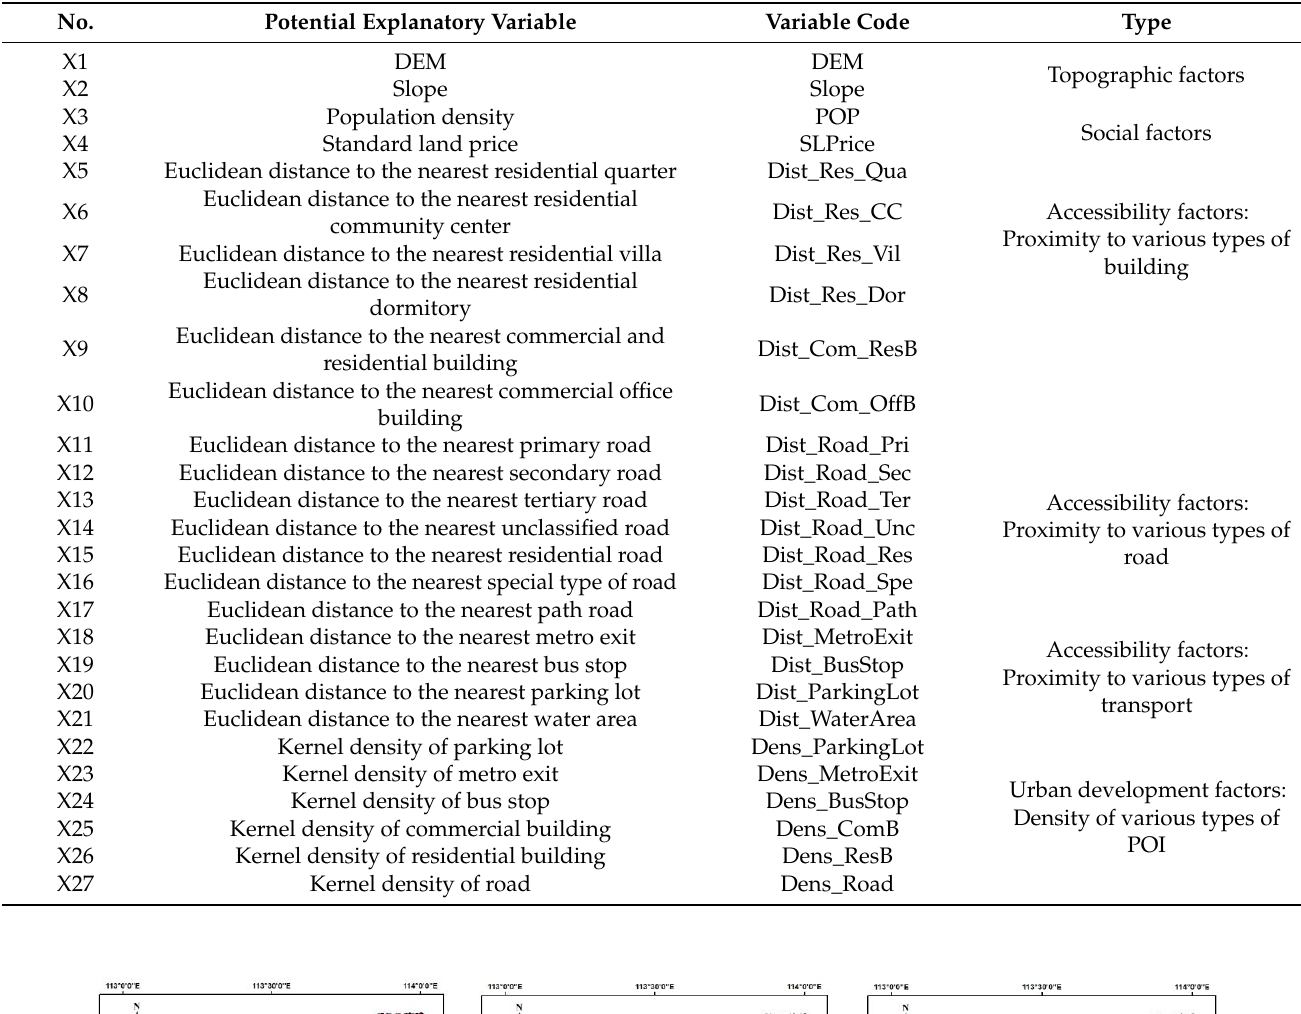
Table 3. The abbreviations of the 27 candidate variables.